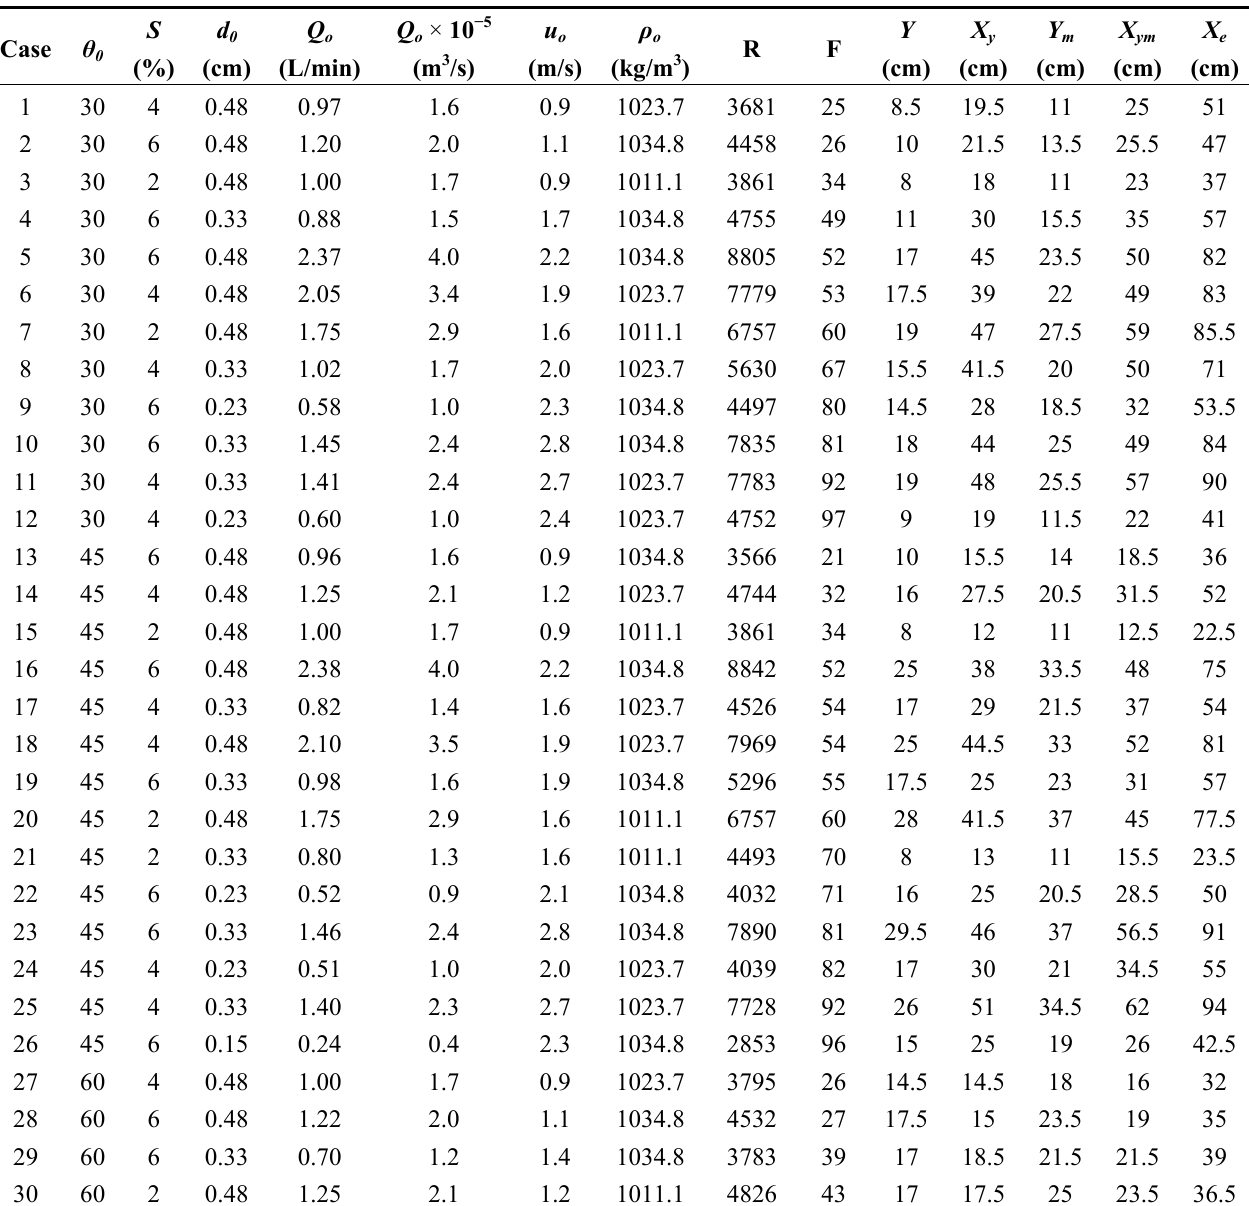
Table 1. Summary of results for the inclined negatively buoyant jet